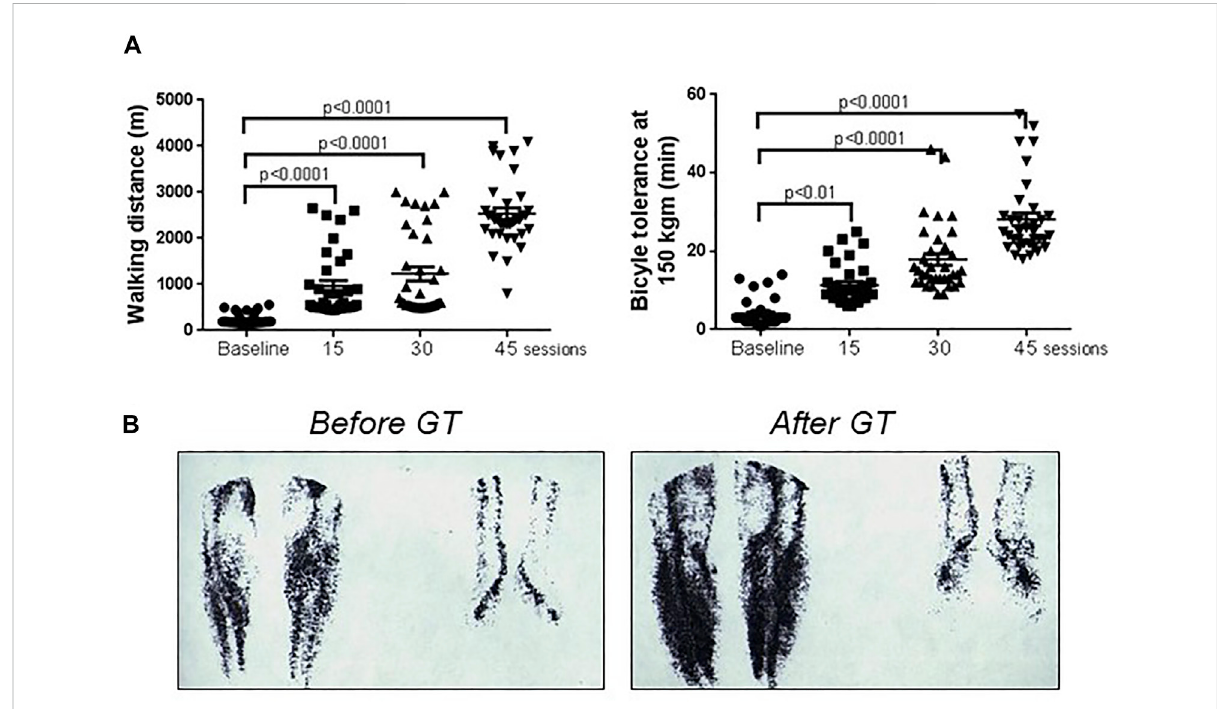
FIGURE 2 Evolution of patients with peripheral artery disease with gravitational therapy. (A) Functional recovery of 35 PAD patients with intermittent claudication (Fontaine stage II) evaluated through total walking distance (left chart) and bicycle tolerance at 150 kgm/min (right chart) following